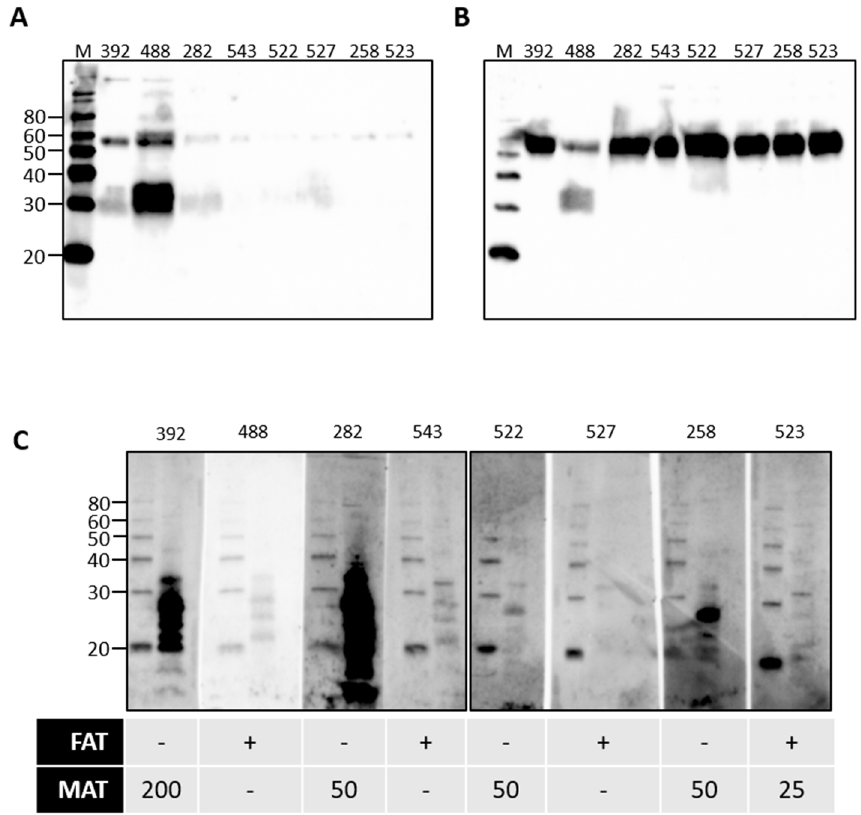
Figure 5. Detection of urinary IgG ( A ) or urinary IgA ( B ) in the urine of cattle that were naturally exposed to leptospires. Urinary IgA specific for leptospires from naturally infected cattle was demonstrated by immunoblotting of leptospires ( C ). The diagnostic status of each animal (numbered at the top of each gel) is provided for the fluorescent antibody test (FAT-positive [+] or -negative [-]) and the microscopic agglutination test (MAT) at 1:25 or above. Molecular mass markers (M) are indicated in kDa.